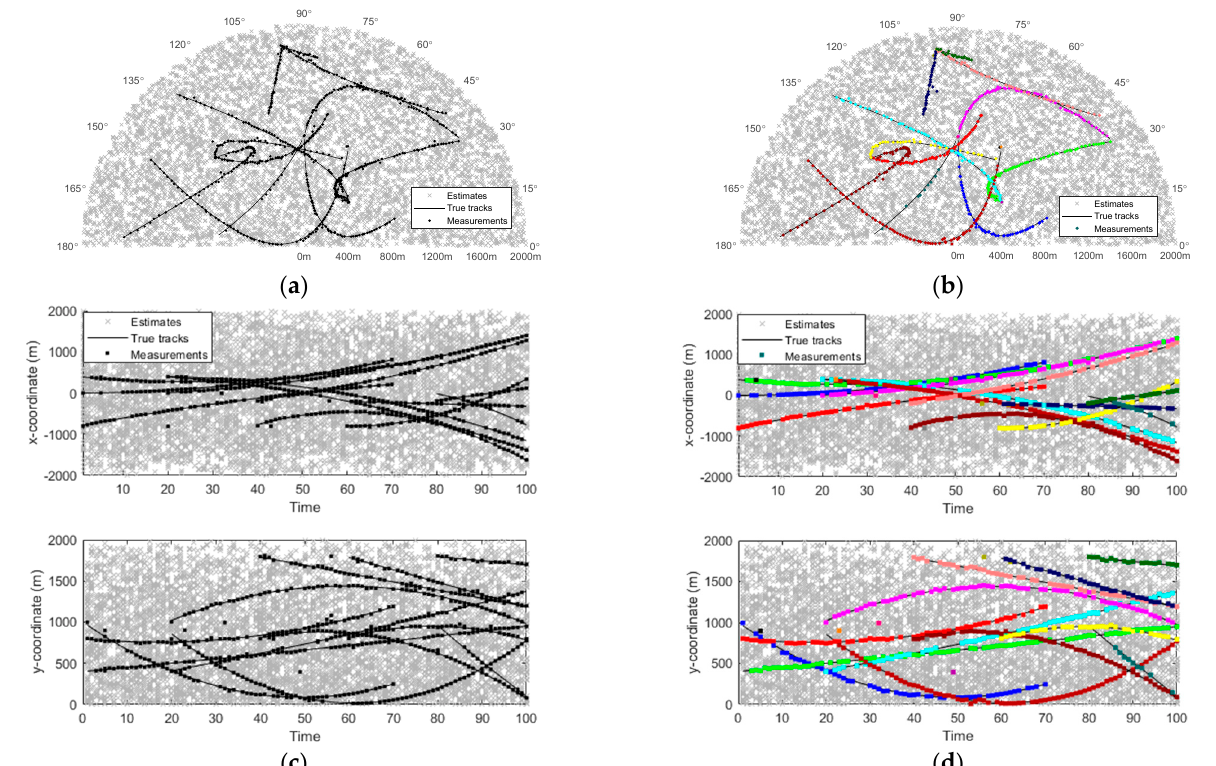
Figure 12. The estimations of the multi-target trajectories and the actual measurements in example 2 (CA motion model) for a sample run. ( a ) The actual measurements, actual trajectories and estimated trajectories obtained after filtering by the SM-GM-PHD filter for T s = 1 s ( T i = 2 ms, λ = 104, p D , k = 0.8). ( b ) The actual measurements, actual trajectories and estimated trajectories obtained after filtering by the SM-LGM-PHD filter for T s = 1 s, and the different trajectories are denoted by different color dots. ( c ) The actual measurements, actual trajectories and estimated trajectories obtained after filtering by the SM-GM-PHD filter in x and y coordinates for T s = 1 s. ( d ) The actual measurements, actual trajectories and estimated trajectories obtained after filtering by the SM-LGM-PHD filter in x and y coordinates for T s = 1